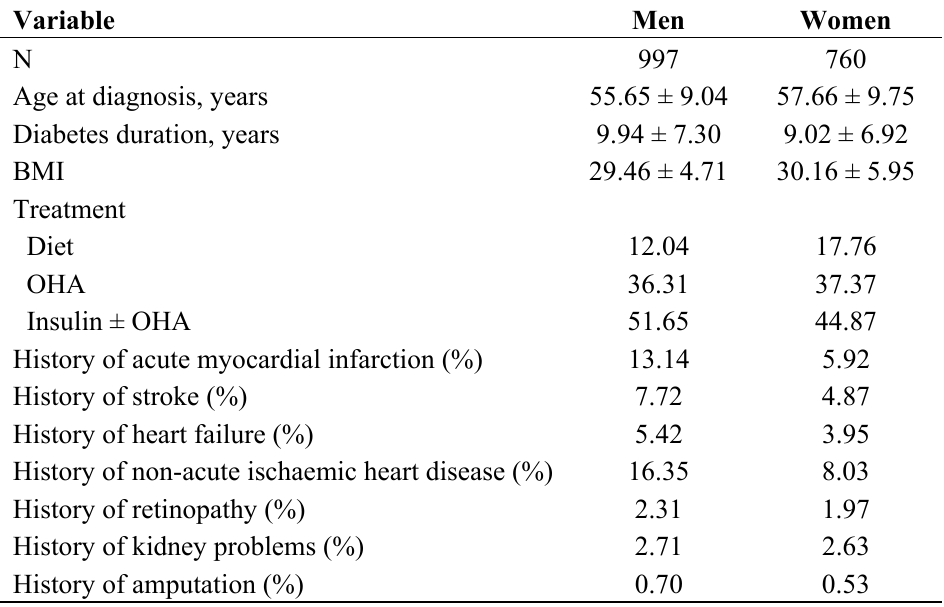
Table 1. Patients’ demographic and clinical characteristics divided by